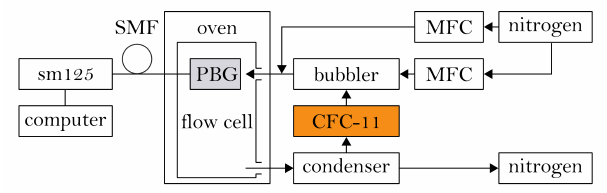
Figure 4. Schematic illustration of the experimental setup depicting the static optical sensing interrogator, the temperature-controlled gas-flow chamber containing the sensor, and the gas mixing